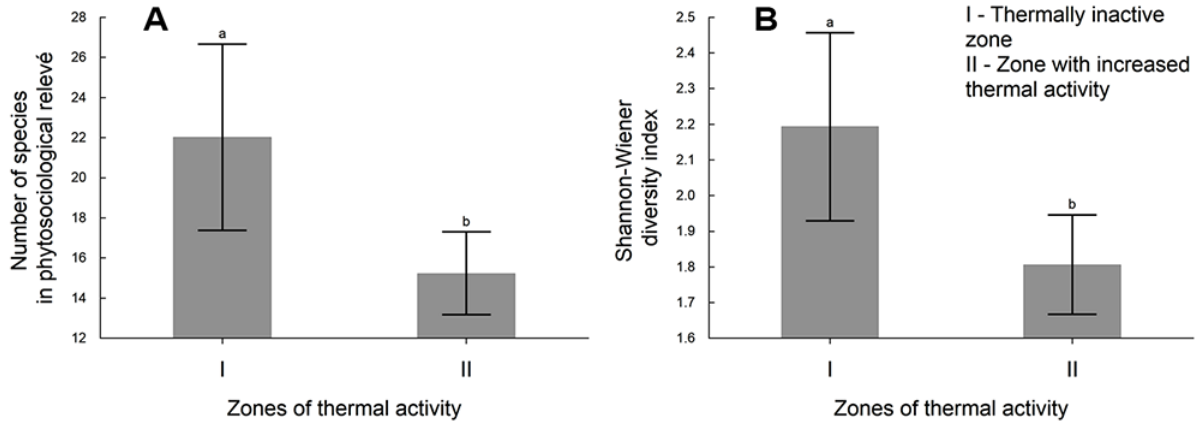
Fig. 3 Comparison of the zones with different levels of thermal activity on the postmining “Ruda” heap in relation to species richness ( A ) and species diversity ( B ). The zones examined are significantly different in terms of species richness ( Z = 2.13, p = 0.03) and species diversity ( Z = 2.29, p = 0.02) according to the Mann–Whitney nonparametric U test. The values represent means ± standard deviation.